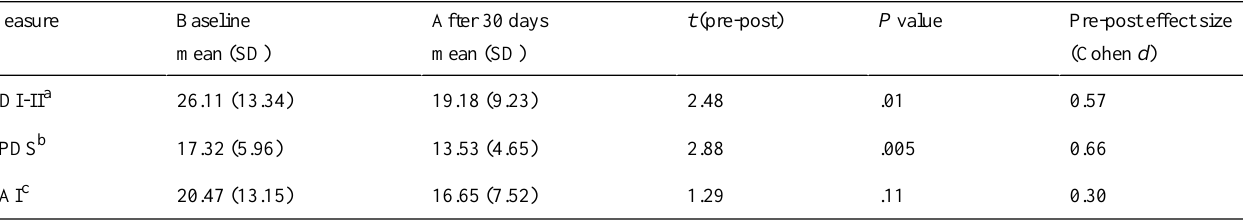
Table 4. Intent-to-treat (n=19) means and standard deviations of self-reported outcome measures filled by intervention group over a 30-day